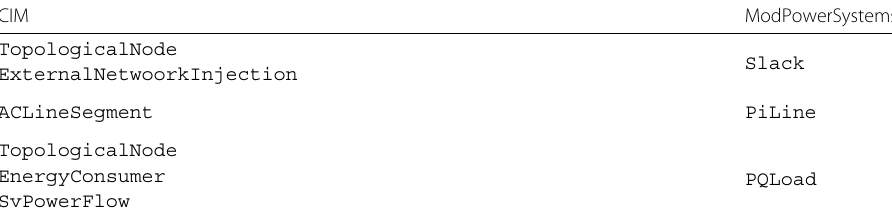
Table 2 Excerpt of further important mappings from CIM to ModPowerSystems as implemented in the Modelica